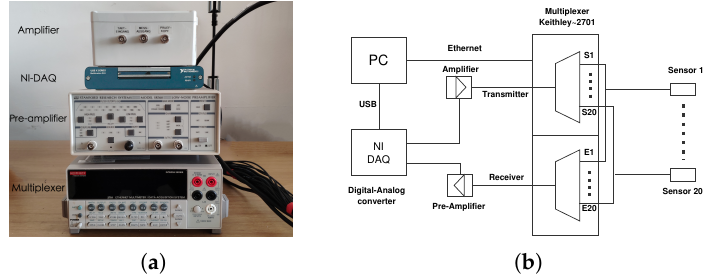
Figure 4. ( a ) Data acquisition devices ( b ) Diagram of the data acquisition system.